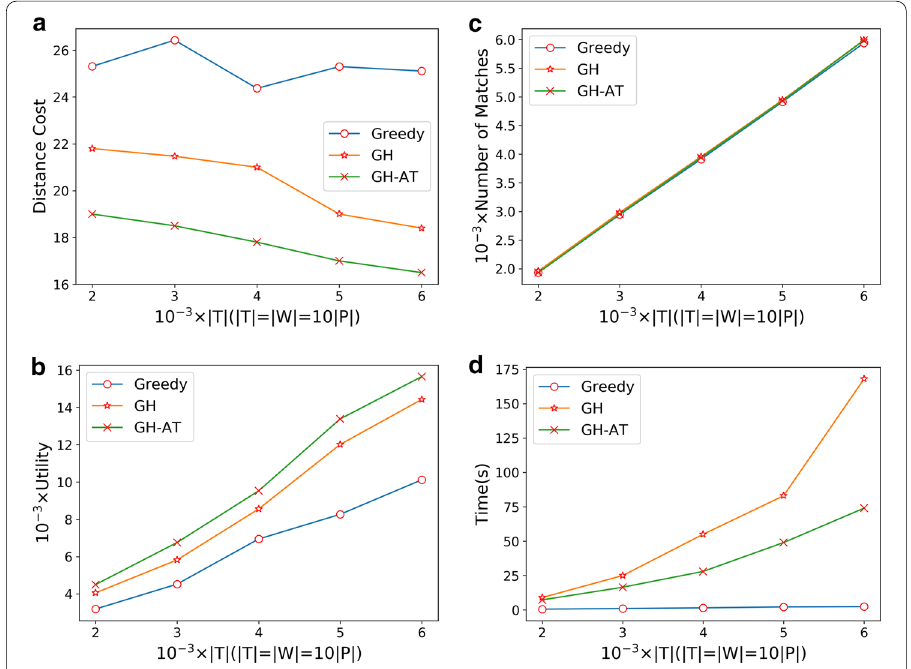
Fig. 5 Varing the number of